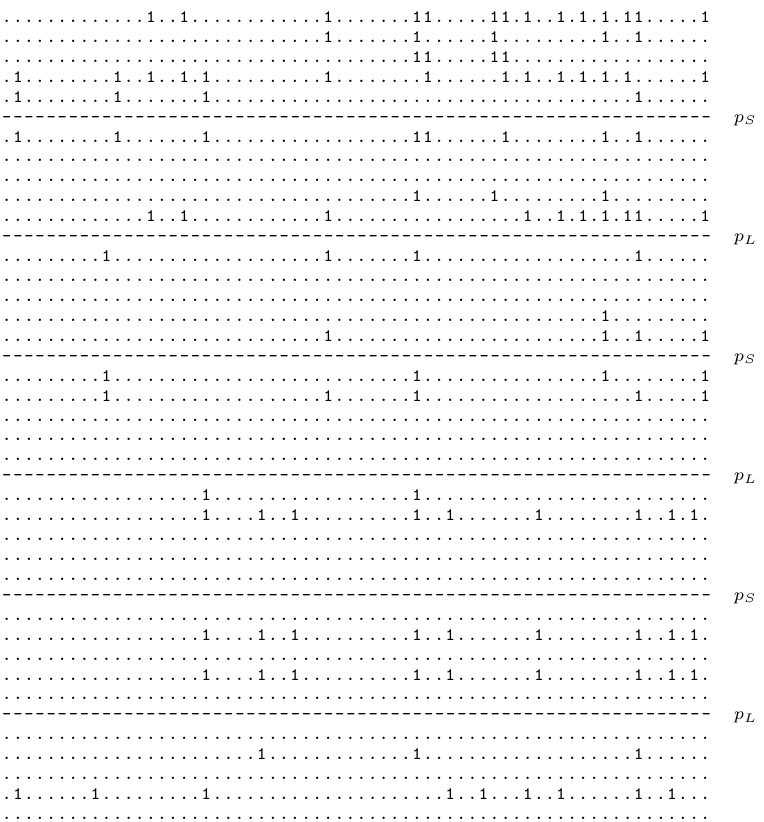
Figure 13: 4-round linear trail with 43 [17, 6, 9, 11] active Sboxes and correlation 57 [19 9 18